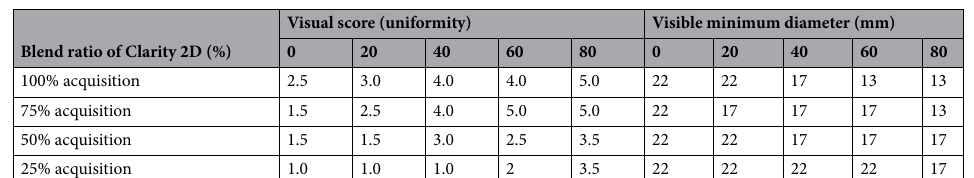
Table 1. Image uniformity score and visible minimum diameter of tumor region for visual assessment. The visual score of uniformity shows the average value by two expert technologists. The visible minimum diameter was determined by the consensus of two expert technologists.